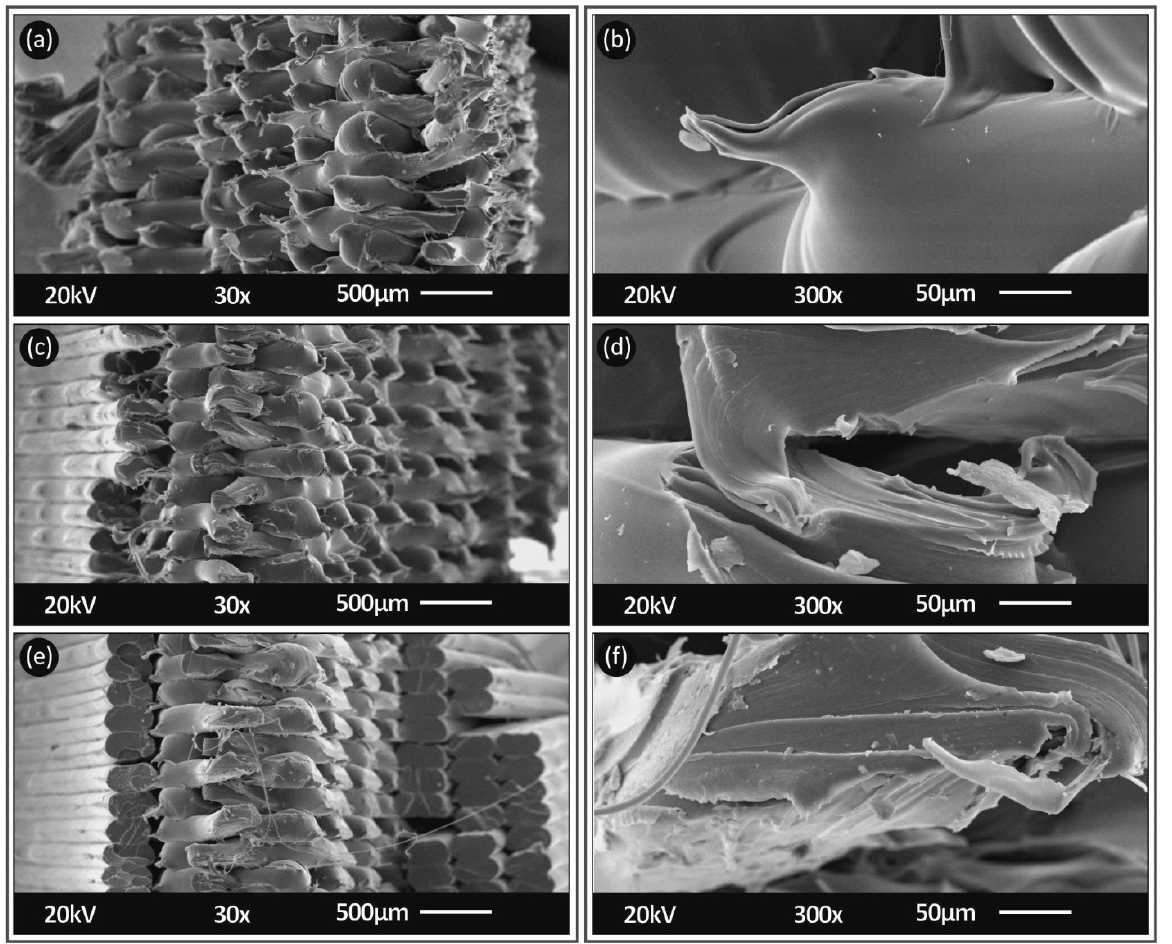
Figure 13. Fracture area SEM captures from TPU specimens (built at a 215 °C nozzle temperature, with a 0.2 mm layer thickness) at different elongation speeds of 10 mm/min ( a , b ), 100 mm/min ( c , d ) and 300 mm/min (e,f) at 30× ( a , c , e ) and 300× ( b , d , f ) magnifications.